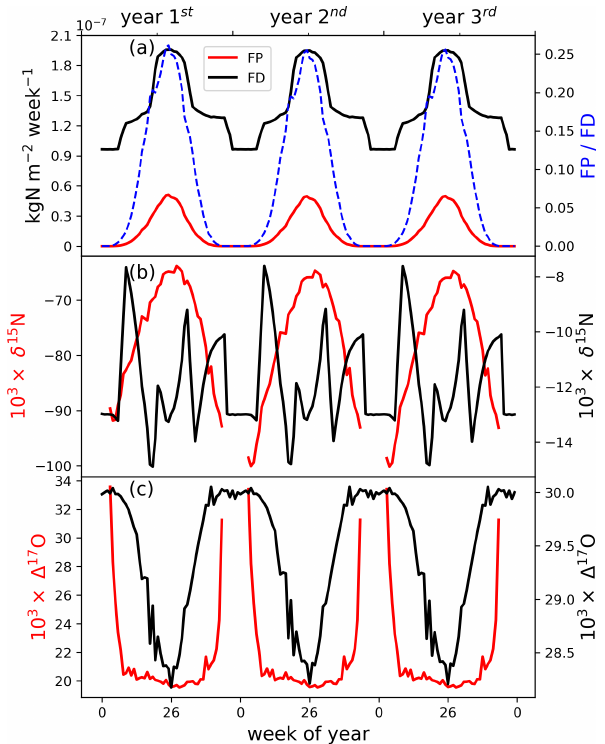
Figure 2. Weekly distribution of photolysis flux (FP) and deposi- tion flux (FD) and their nitrate isotopic compositions. Gaps in FP (red line) are during the winter when there is no sunlight and thus no photolysis. The results shown are those simulated with seasonal variations in the flux and δ 15 N of primary nitrate ( F pri